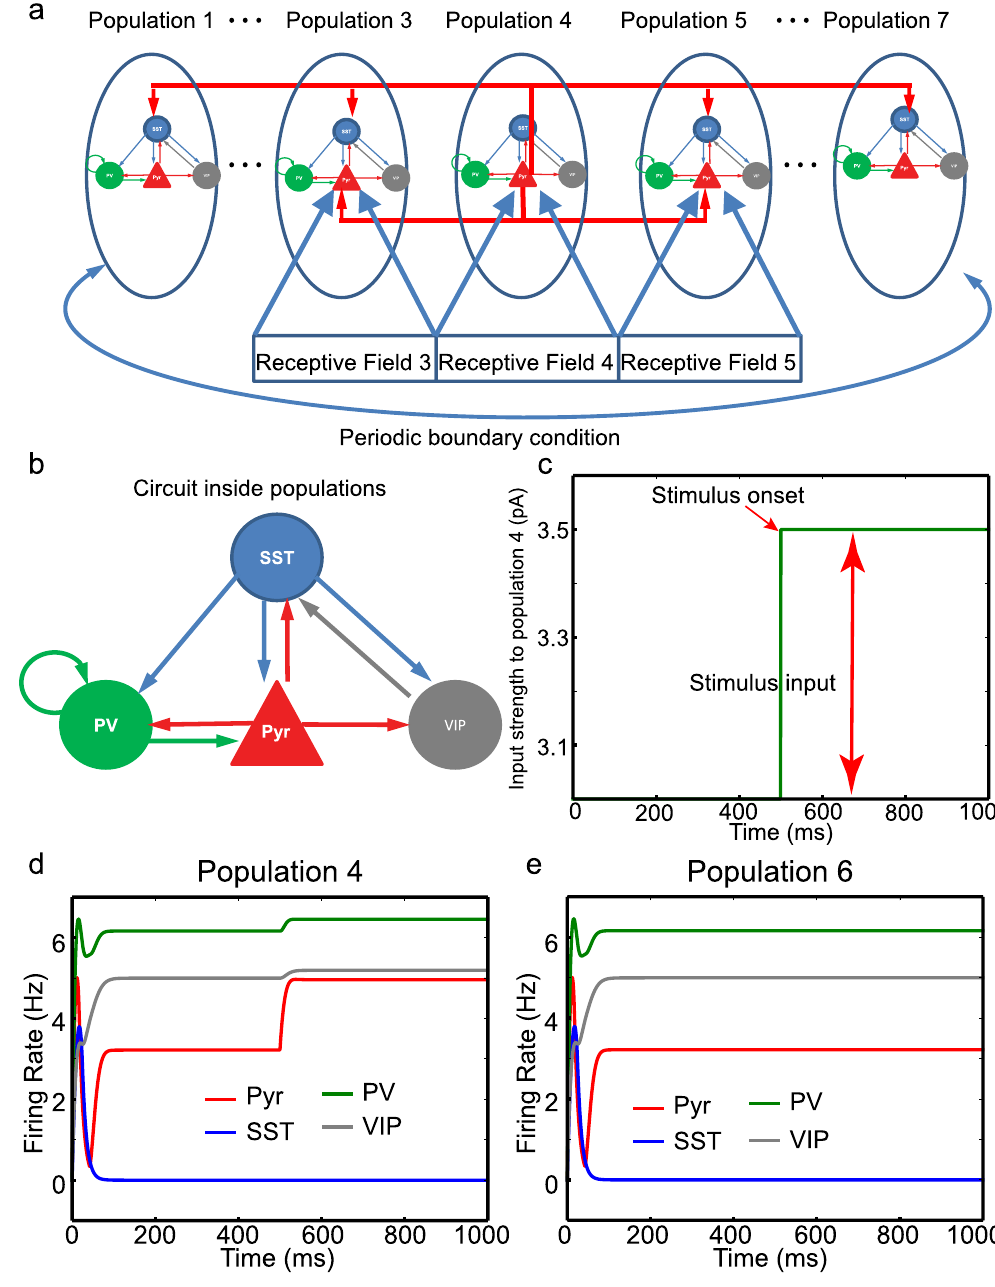
Figure 1. The model structure of firing rate model and its response. ( a ) 7 populations are implemented in the firing rate model, and each population consists of Pyr, SST, PV and VIP cells. They interact with one another via cell type specific connectivity displayed in ( b ). Pyr, PV, SST and VIP are shown in red, green, blue and gray, respectively. ( c ) The time course of input to Pyr cell in population 4. The onset of stimulus presentation is 500 ms marked by the red arrow. ( d and e ) Cell type specific activity in populations 4 and 6, respectively, when all inter- population Pyr-SST connections (IPPS) are removed. All other populations, which are not shown explicitly, have identical responses to those of populations